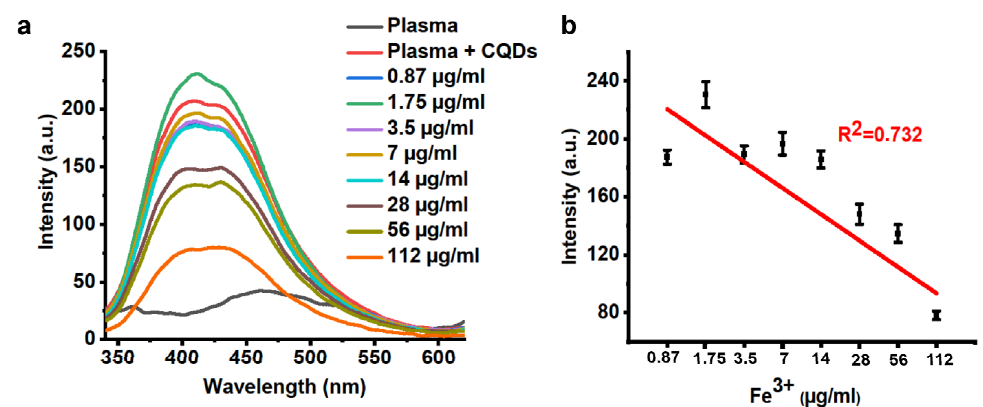
Figure 6. The change in PL spectra ( a ), and the linear relationship between intensity and concentra- tions ( b ), of CQDs in blood plasma in the presence of Fe 3+ ions at different concentrations. The PL data were collected at ex: 320 nm. All analyses were repeated three times and average results were represented.